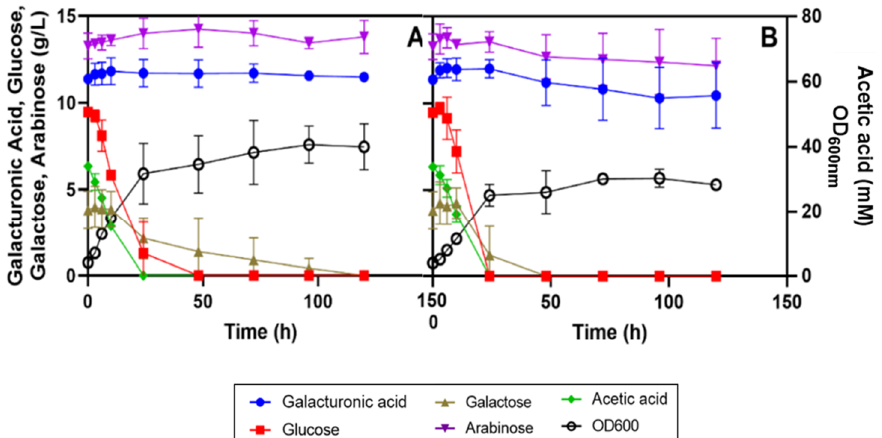
Figure 2. Growth curves and carbon source utilization by ( A ) Rhodotorula mucilaginosa IST 390 and ( B ) Rhodotorula toruloides PYCC 5615 cultivated in sugar beet pulp (SBP) hydrolysate H11-derived medium. SBP hydrolysate H11 was 5 g/L of ammonium sulphate, adjusted to pH 5.0 and inoculated with an initial optical density at 600 nm (OD 600 nm ) of 4. Yeast cultivations were performed at 30 °C with orbital agitation (250 rpm). The data are means of two independent experiments and bars represent standard deviations (SD).